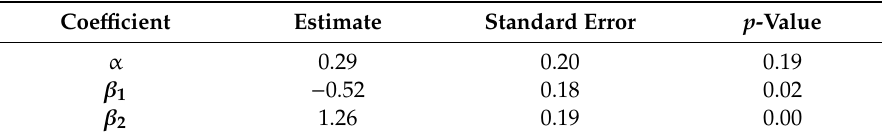
Table 4. MLR model coefficient estimates, standard errors and p -values.